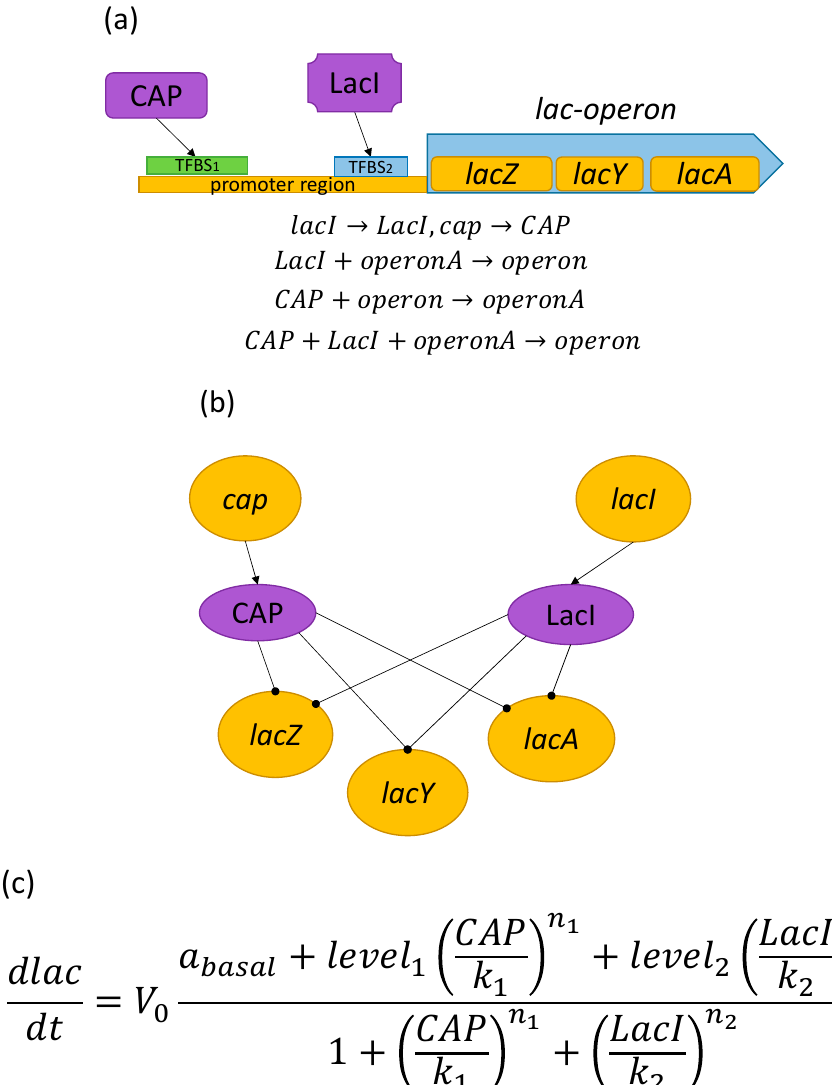
Figure 1. Lac-operon: from the biochemical scheme to a mathematical model. ( a ) Depiction of the operon and promoter’s structure. Here, CAP and LacI are transcription factors (TFs); TFBS is a transcription factors biding site (DNA region in the promoter to which TF binds); lacZ, lacY, and lacA are the genes included in the operon; operon and operonA are the operon’s inactive and active forms, respectively. Repressor (LacI) binding converts the active into the inactive form, and the activator (CAP) acts in the opposite way, and simultaneous CAP and LacI binding leaves the operon inactive. ( b ) Graphical representation of a transcription regulation network (TRN) where the yellow and purple nodes are genes and TFs, respectively, and the arrowed and capped edges mark synthesis and regulation. ( c ) A mathematical TRN-based model describing lac-operon regulation.